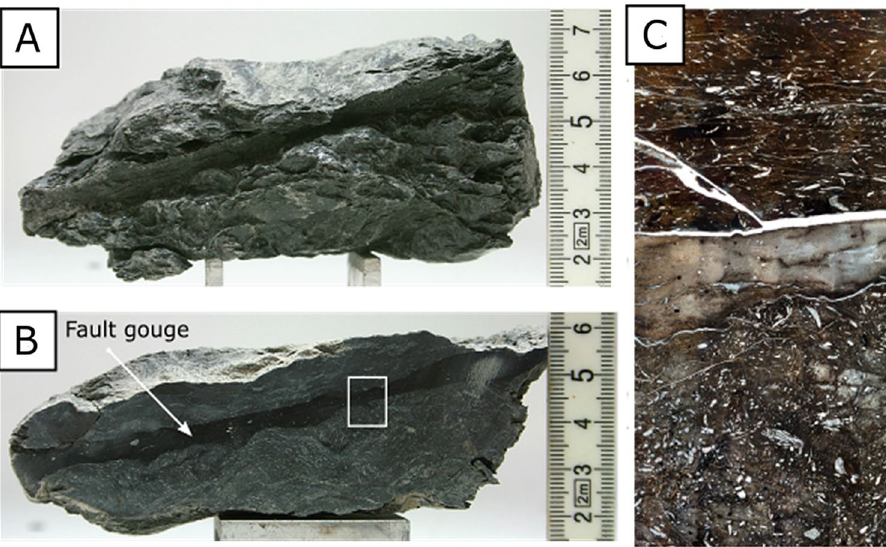
Figure 2. ( a ). A fault gouge sample collected from borehole BFS-2 at the Mont Terri Laboratory. ( b ). OPA Fault gouge is characterised as a 1 cm thick and dark layer, surrounded by scale clay texture. Inset (white rectangle) corresponds to figure C. Figure B from Orellana et al . (2018b) ( c ) Thin section image assemblage of the fault gouge sample showing the contact between the fault gouge and the surrounding scaly clay texture. As observed in the figure, the fault gouge is characterized by a strong reduction in the calcite content and small grain size, compared to the surrounding host rock. Image is in cross-polarized